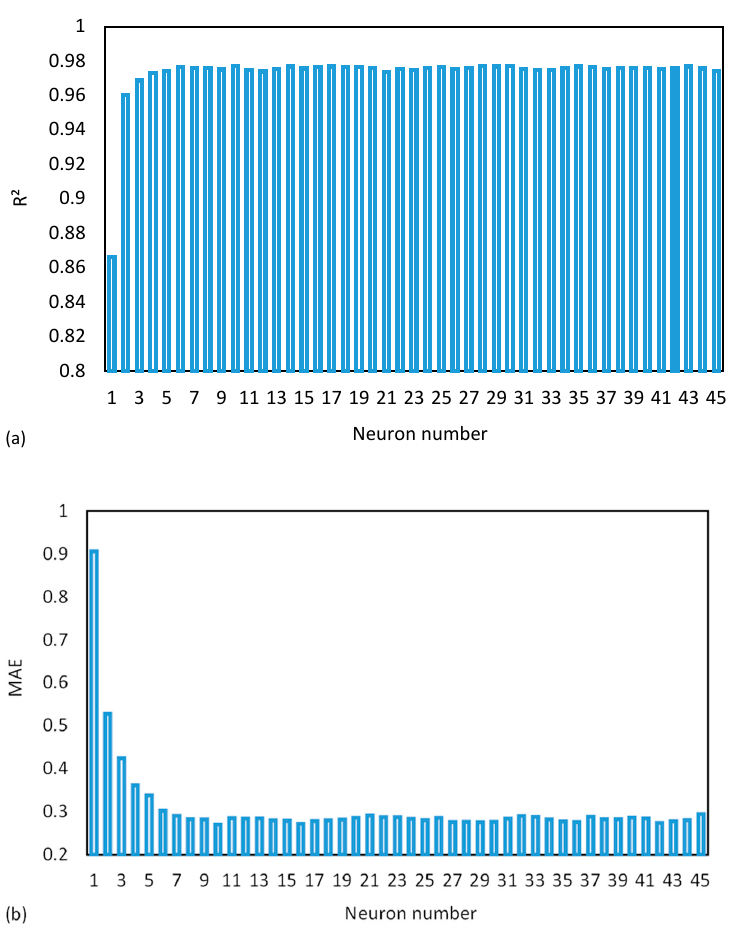
Figure 9. The ( a ) accuracy ( R 2 ) and ( b ) error (MAE) of different numbers of neurons for the training database in the ANN model.